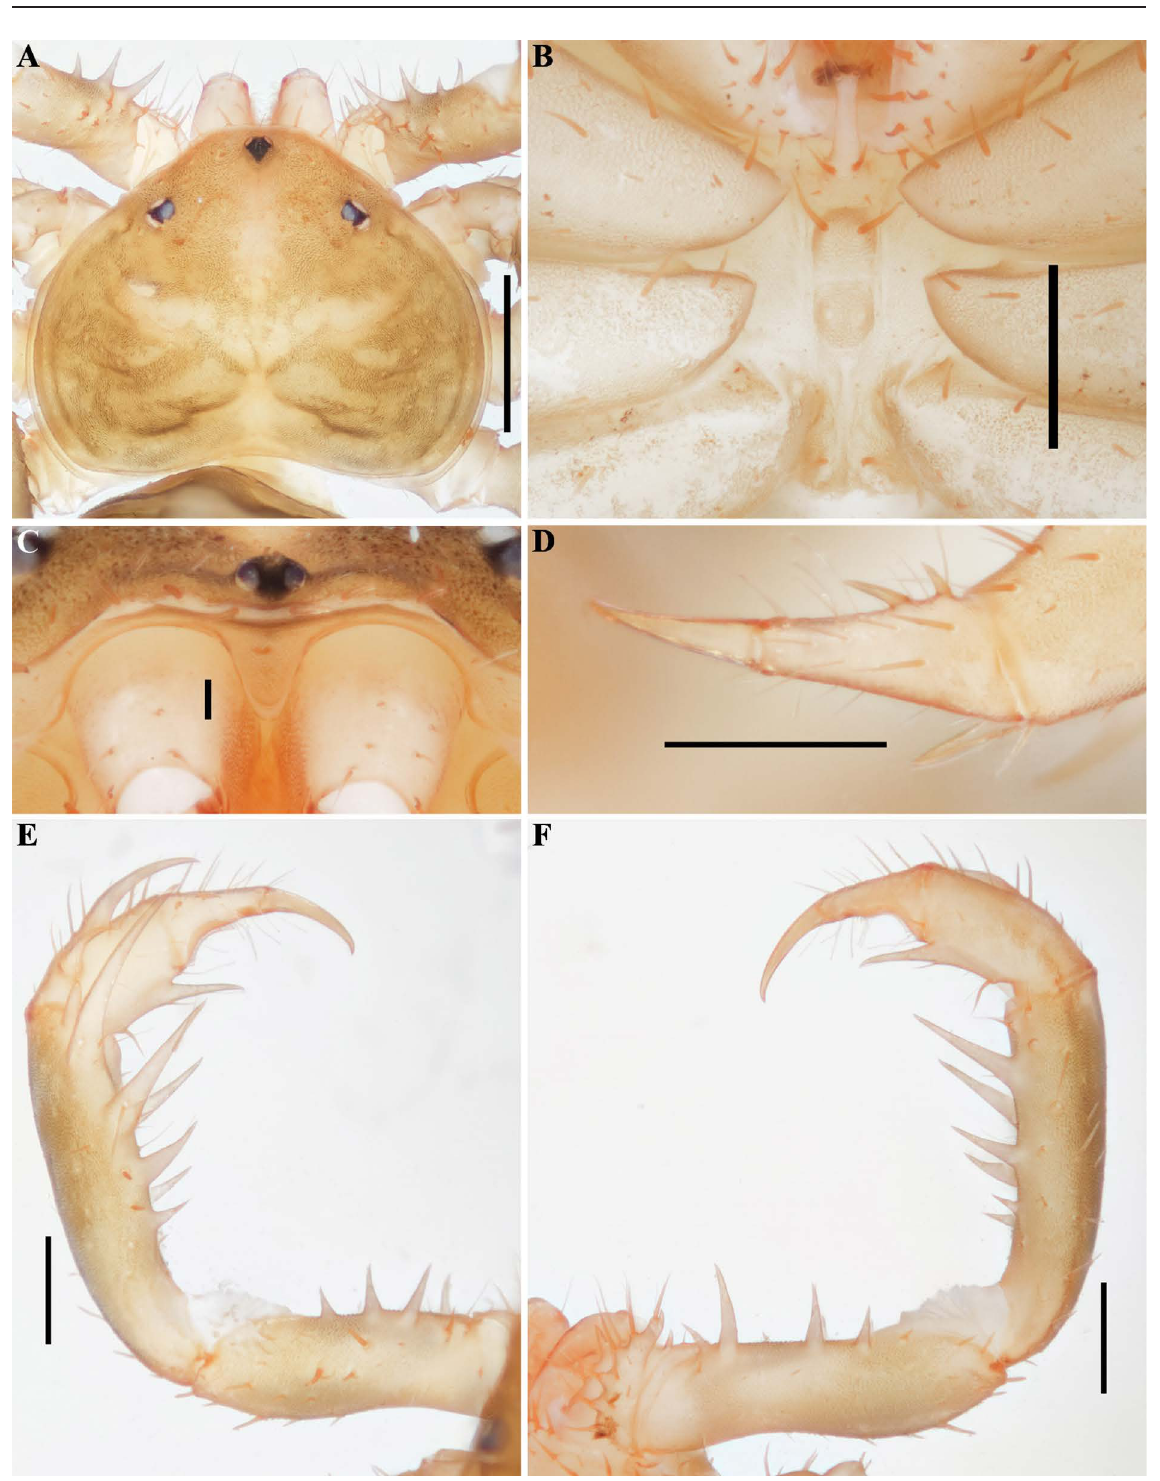
Fig. 31. Charinus palikur sp. nov. (AMCC [LP 3832]), general morphology, ♂. A . Carapace, dorsal view. B . Sternum, ventral view. C . Frontal process. D . Pedipalp tarsus, frontal view. E . Pedipalp, dorsal view. F . Pedipalp, ventral view. Scale bars: A = 1 mm; B, D–F = 0.5 mm; C =